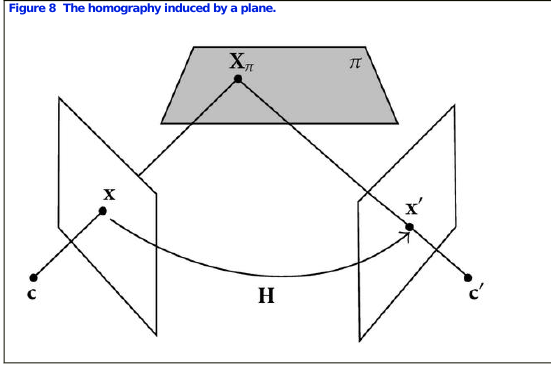
Figure 8 The homography induced by a